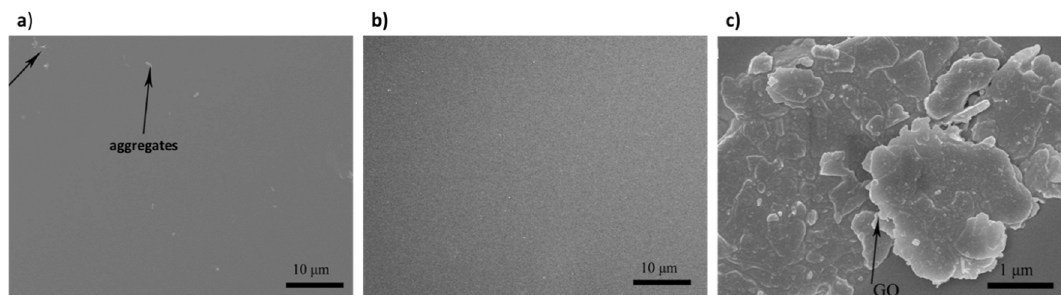
Figure 15. SEM images of ( a ) the MWCNTs/urushiol formaldehyde polymer (UFP) and ( b ) the GO/MWCNTs/UFP films ( c ) after its deposition on a silicon substrate (adapted from [47]).